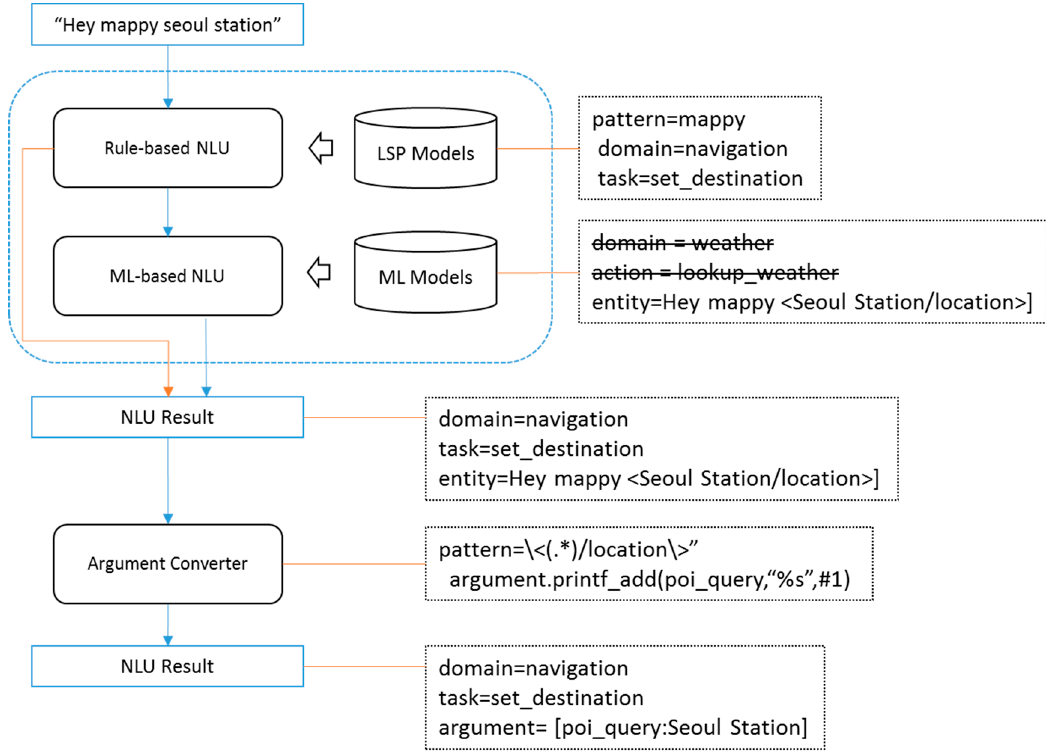
Figure 7. Example of NLU and AC.